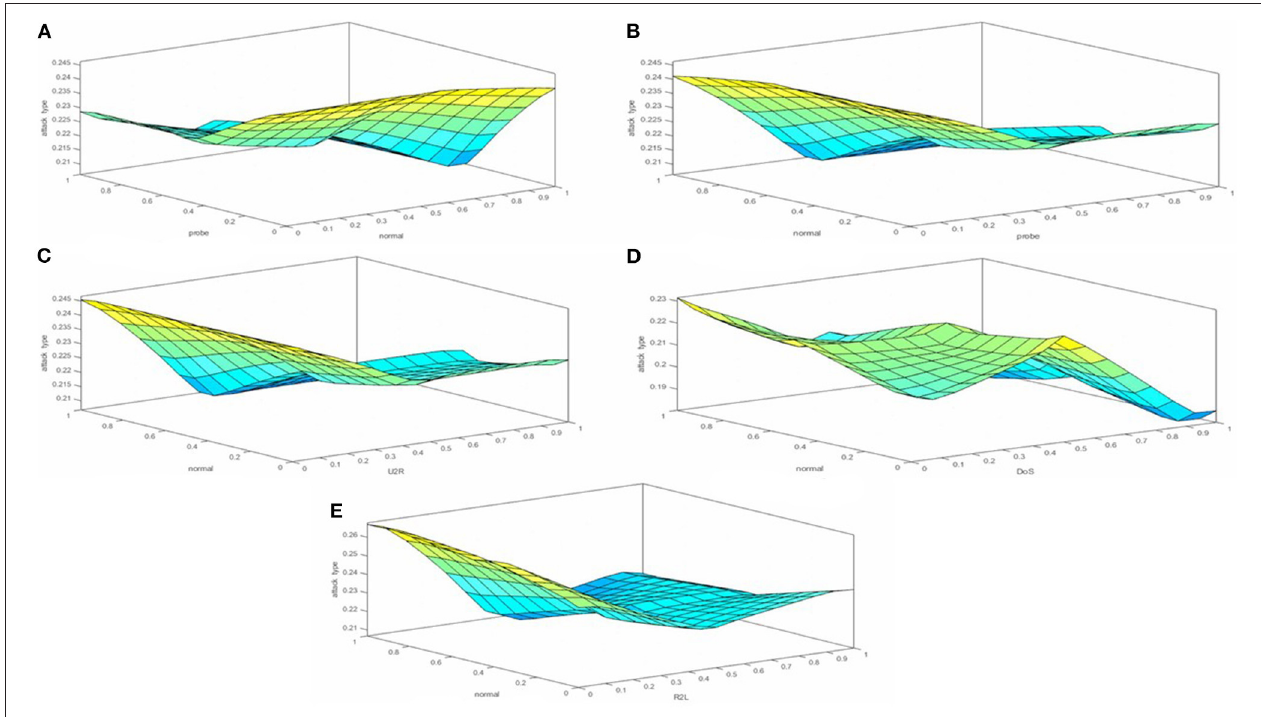
FIGURE 8 | Training results of the KDDcup 99 dataset. (A) On x-axis “normal”. (B) On x-axis “probe”. (C) On x-axis “U2R”. (D) On x-axis “DoS”. (E) On x-axis “R2L”.